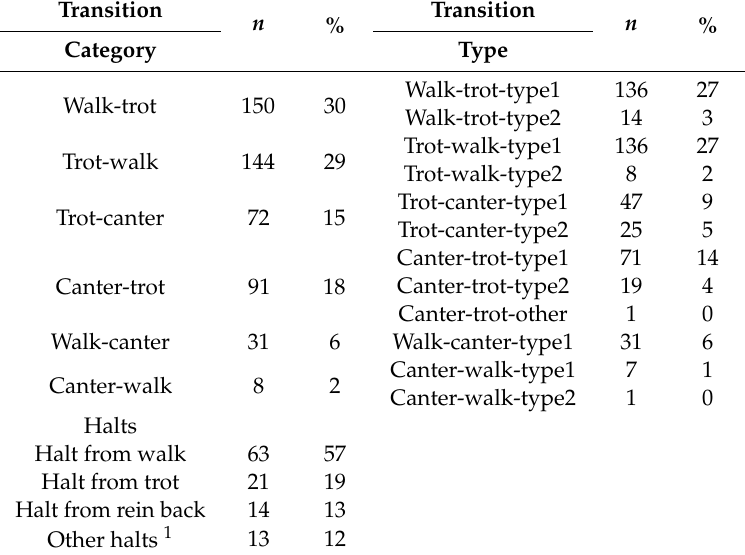
Table 1. The frequency of transition ( n = 496) categories and types, and transitions to halt ( n = 101) with right rein tension data (there was partial data loss for the left rein, Table